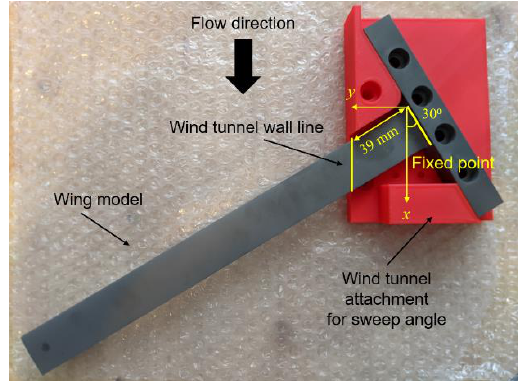
Figure 7. A picture of the flutter model in the vicinity of the root. Table 5. Surface roughness of the flutter wing model at different locations.